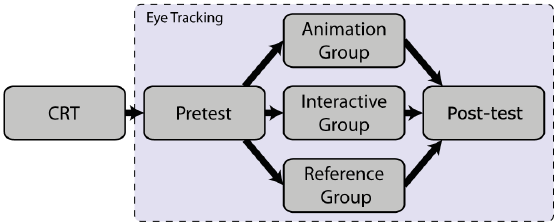
FIG. 3. Illustration of the design of the study. First the subjects worked on the card rotation test. Afterward, eye movements were recorded while the subjects participated in the pretest, the intervention, and the